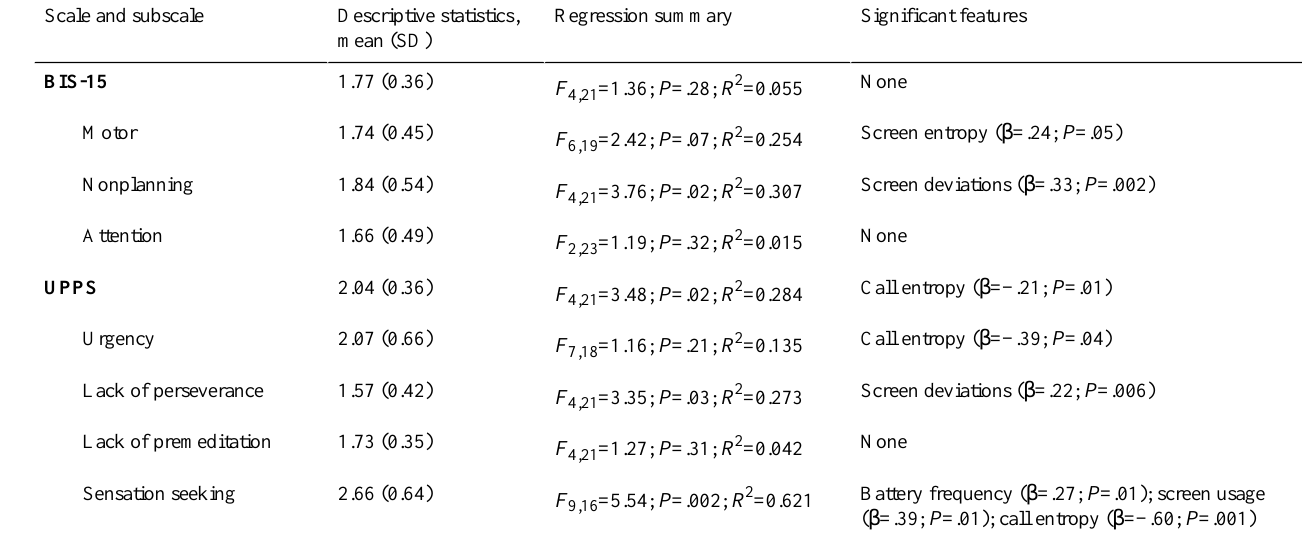
Table 2. Descriptive statistics of laboratory subjective impulsivity and impulsive behavior trait, and regression analysis of mobile sensor data as predictors of impulsivity trait scales and